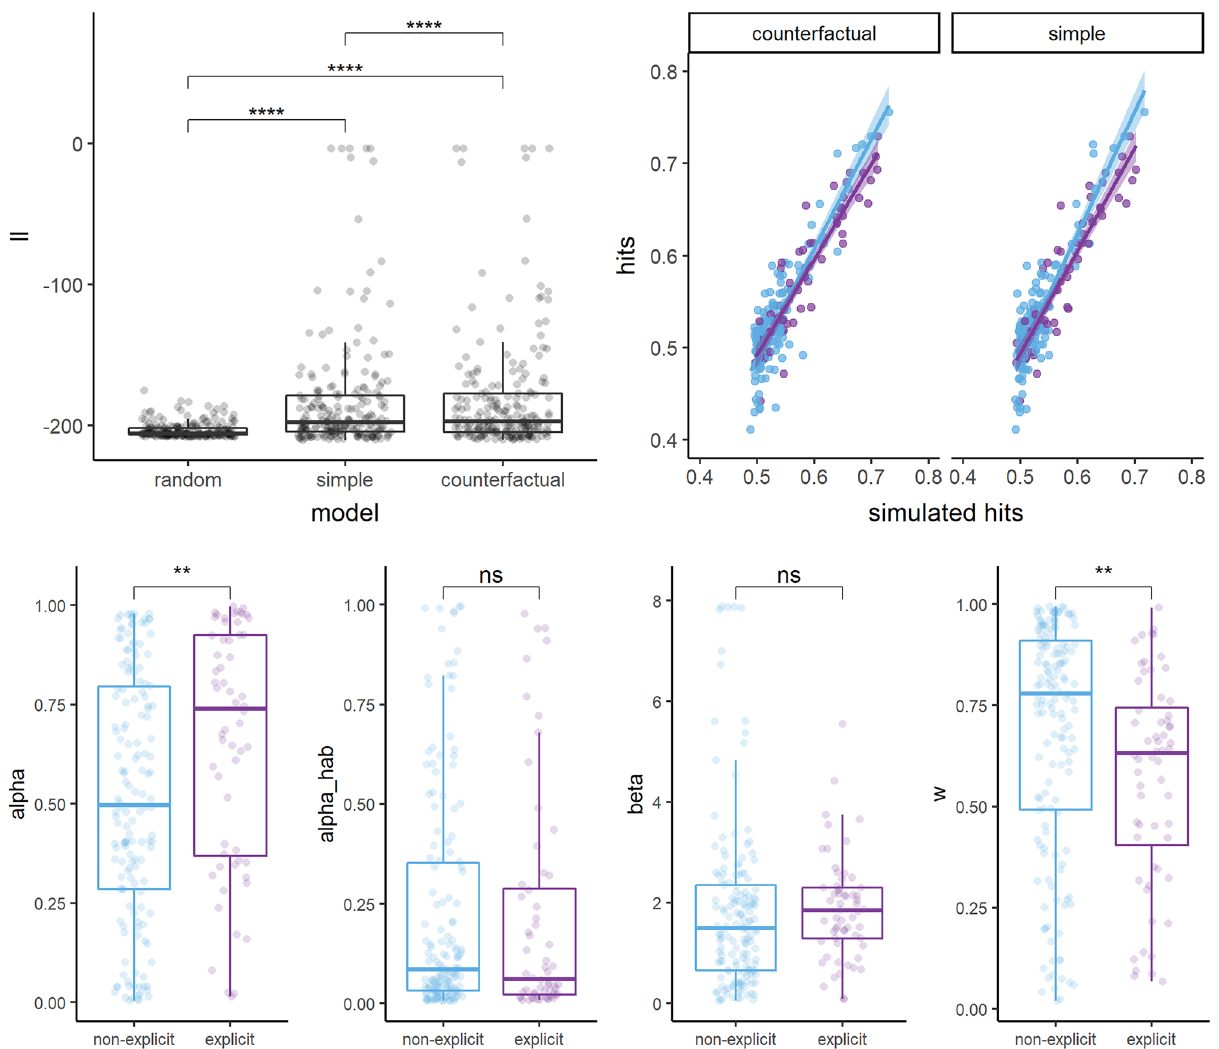
Figure 4. RL models results. Left top, log-likelihood comparison (Wilcoxon paired tests) between the random, simple, and counterfactual models. Right top, correlation between real and simulated mean hit proportions for the simple and the simulated models, as a function of the presence (violet) or the absence (light blue) of an explicit avoidance strategy. Lines represent the best linear fit (and 95% Confidence Interval). Bottom, comparison (Wilcoxon unpaired tests) between the groups with (violet) and without (light blue) an explicit avoidance strategy on subject best fit parameters for the winning counterfactual model. *= p < .05, **= p < .01, ***= p <